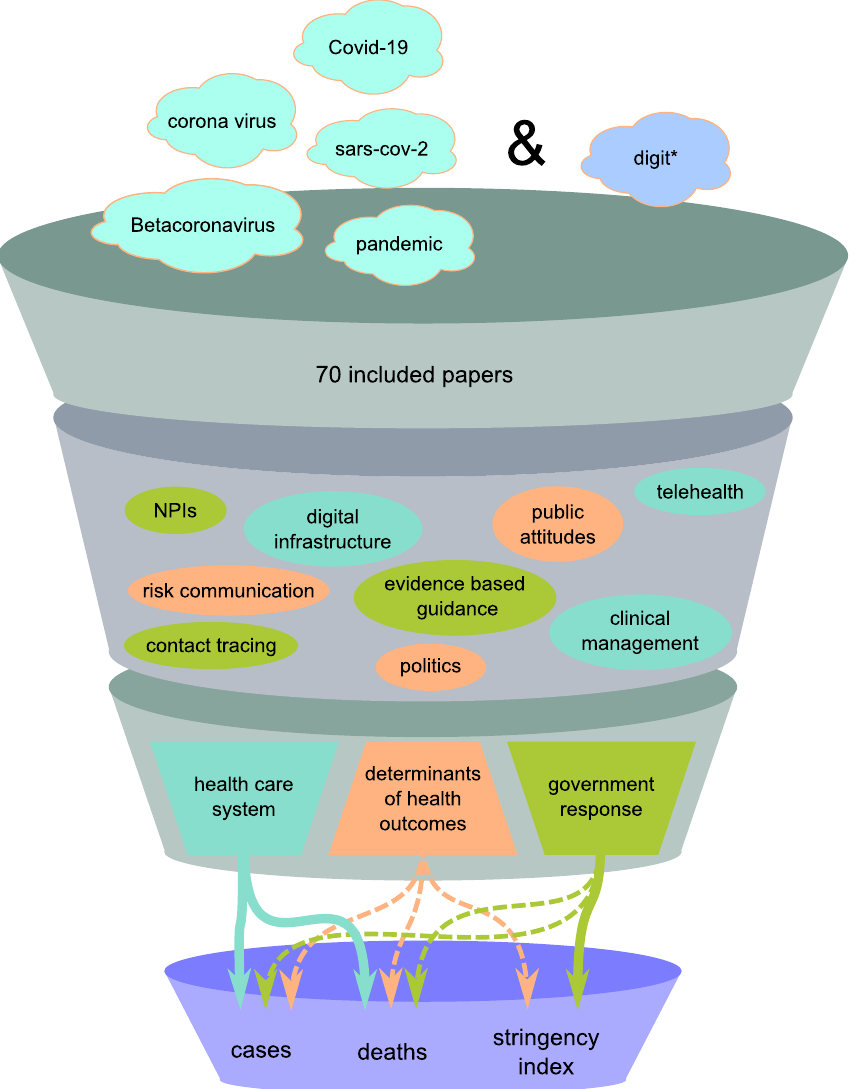
19-related terms (e.g., "Covid-19" OR "sars-cov-2" OR "pandemic") and digit*, which represents the digital domain with different word endings (as indicated by an asterisk (*)). After an extensive selection process,